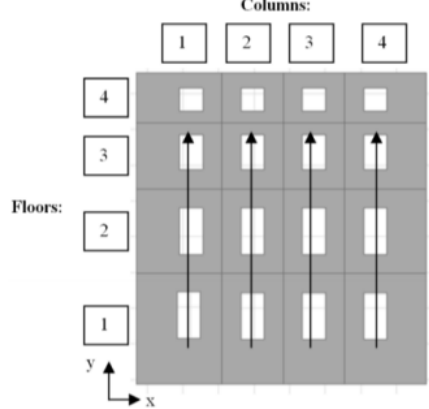
Figure 7. Repeated wall tile resulting from the application of Rule 8 to shape TW.